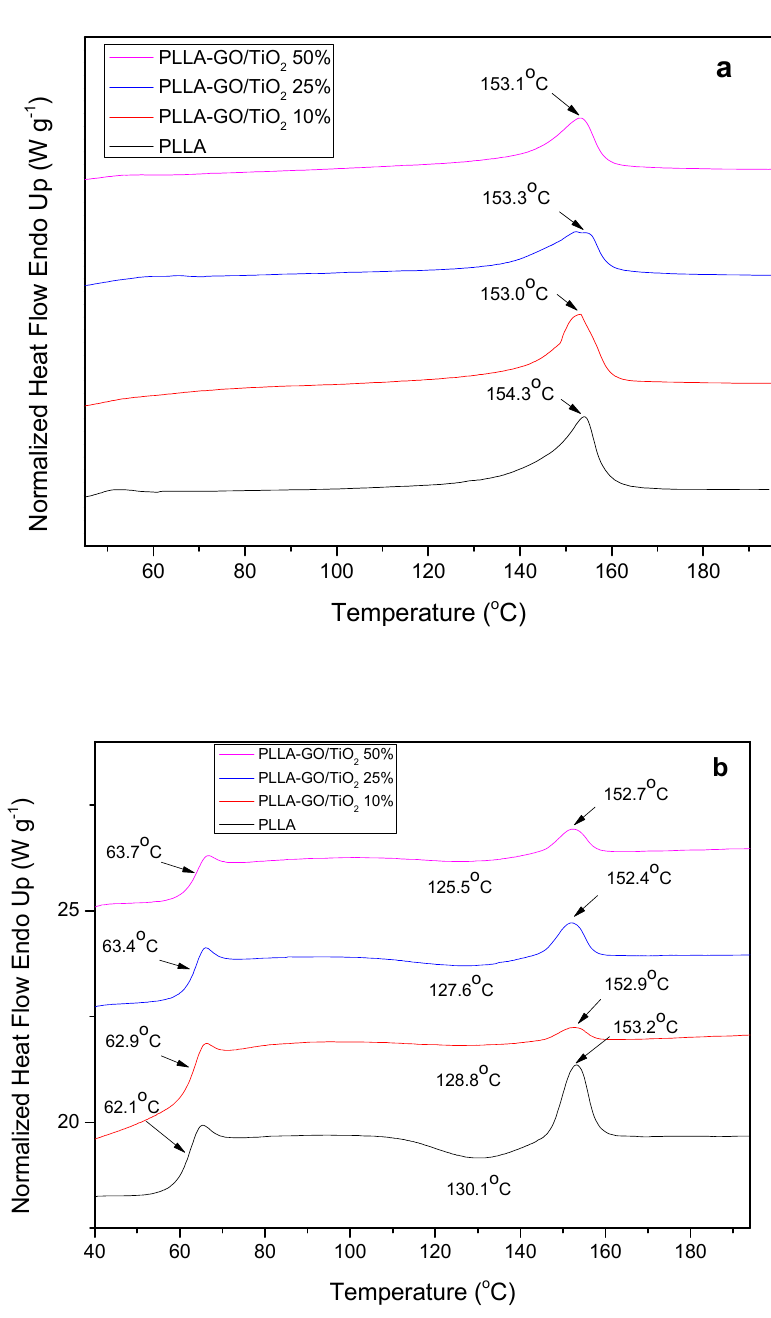
Figure 4. DSC thermogramms of prepared nanocomposites containing different GO-TiO 2 contents in comparison with neat PLLA ( a ) as prepared samples and ( b ) melt quanched samples.